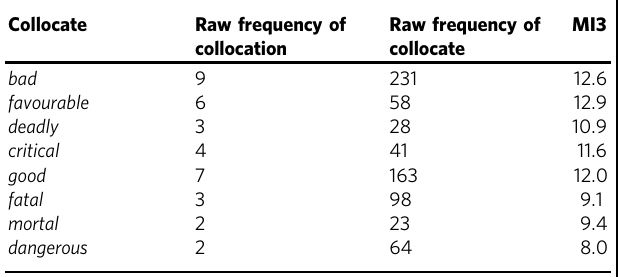
Table 8 Adjective collocates of keyword SIGN, raw frequency = 66.